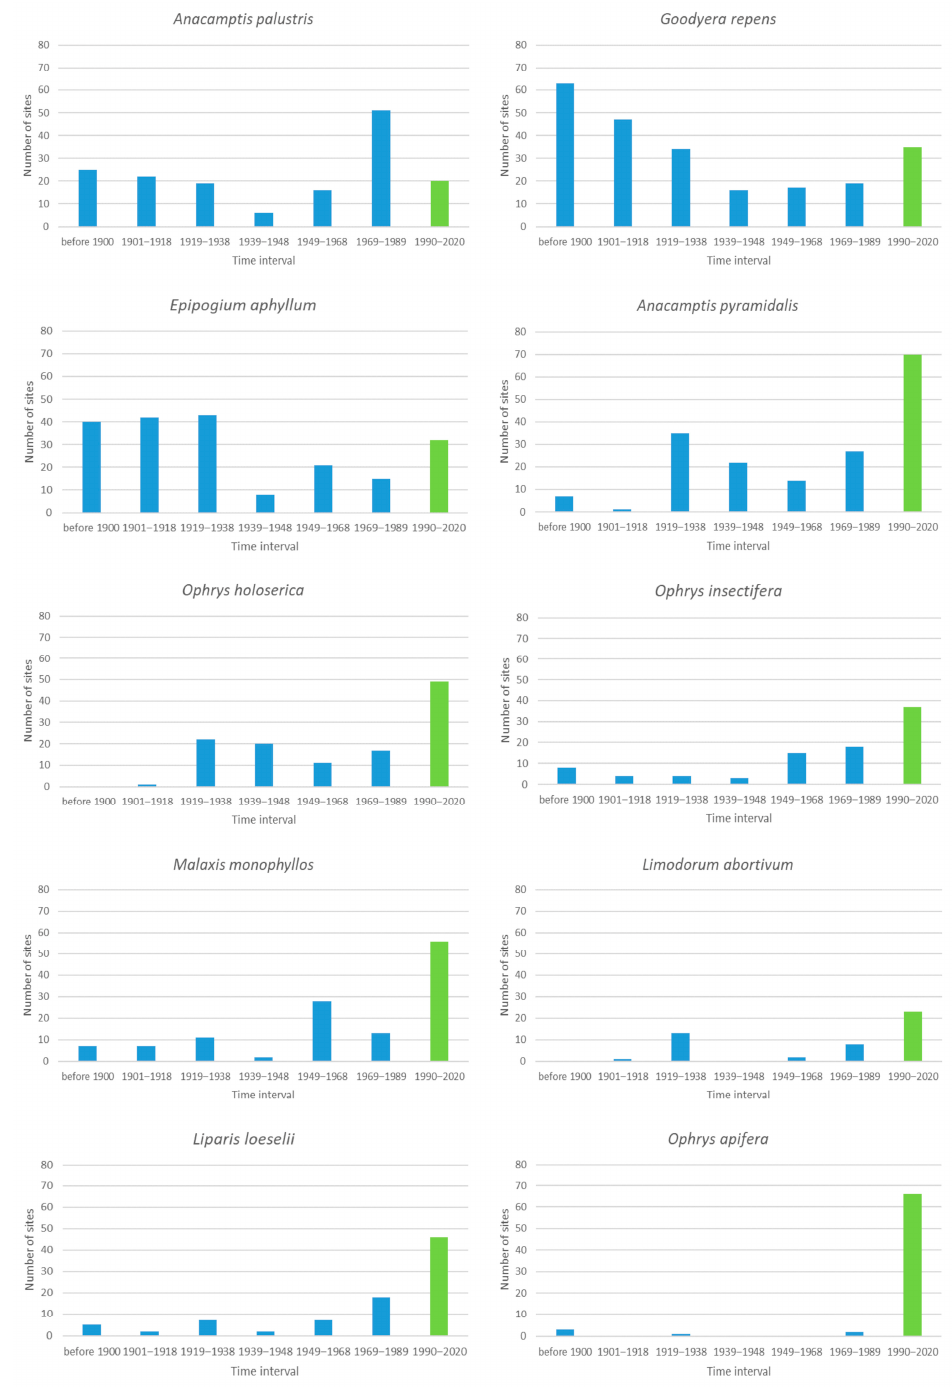
Figure 3. The blue columns are the number of sites that were occupied by orchids for the last time during the given interval and then no longer occupied for the 10 species that were found historically at 21 to 100 sites. The green bar indicates the number of sites occupied in the last interval, which we consider to be the current interval.